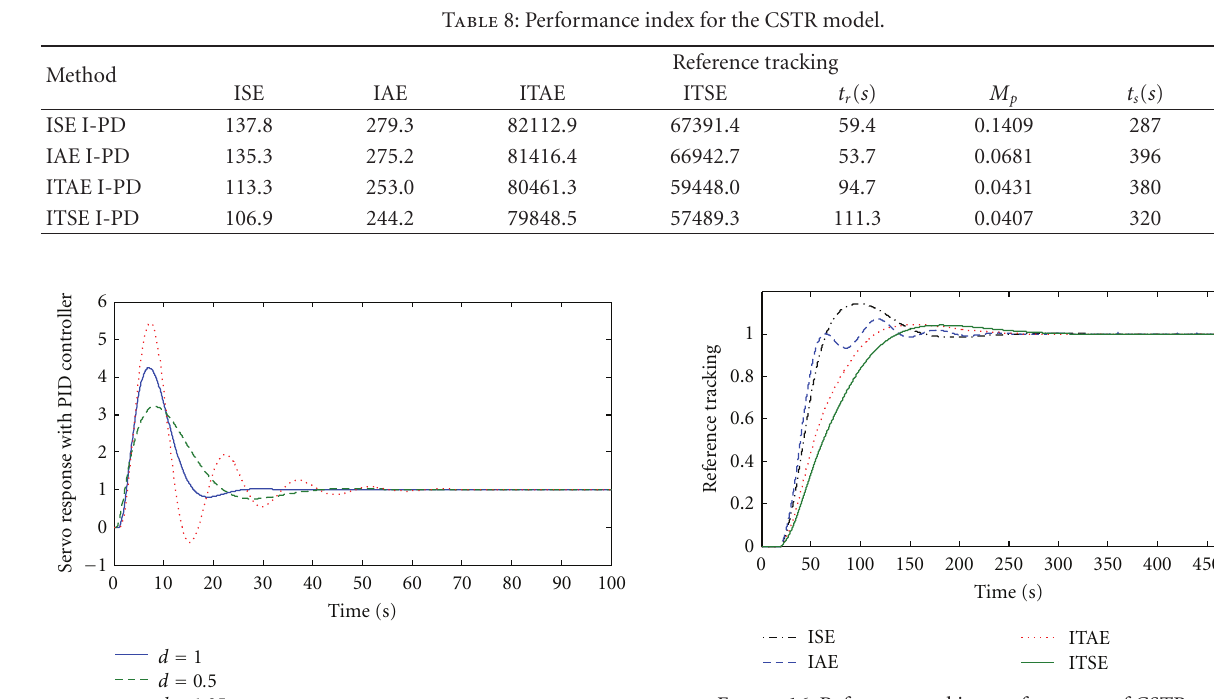
Figure 16: Reference tracking performance of CSTR